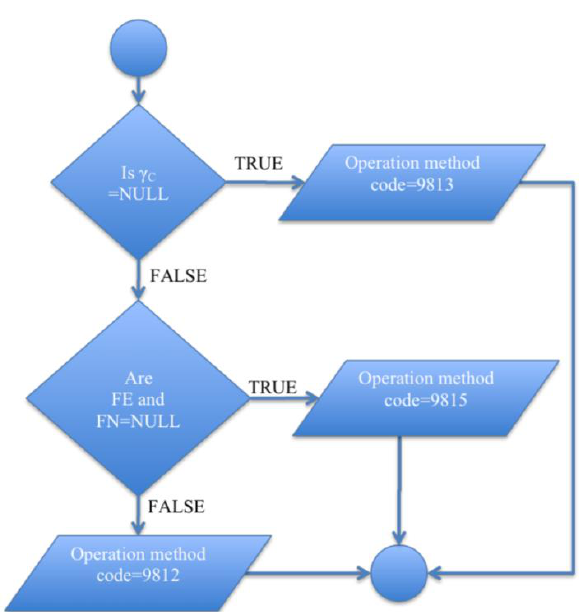
Figure 4. Algorithm to Determine the Map Projection Method Based on The